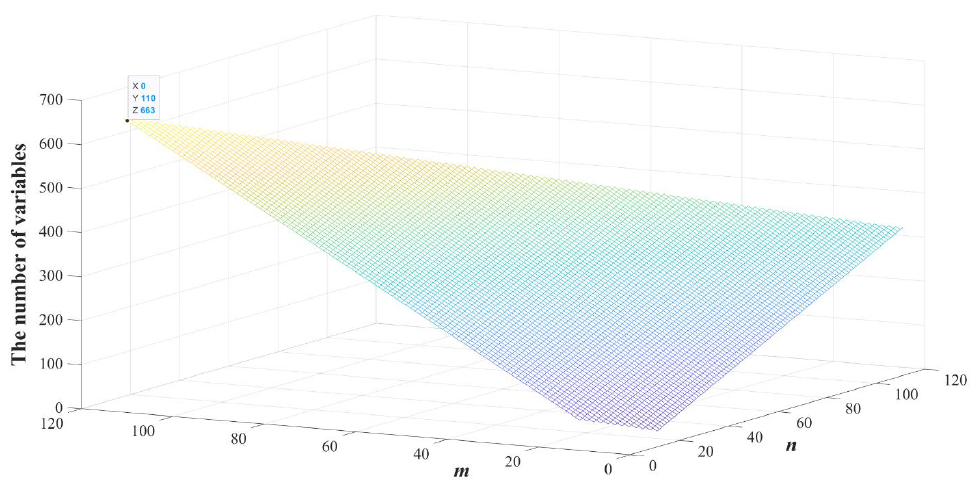
Figure 6. The number of variables of the developed ILP for different cases.